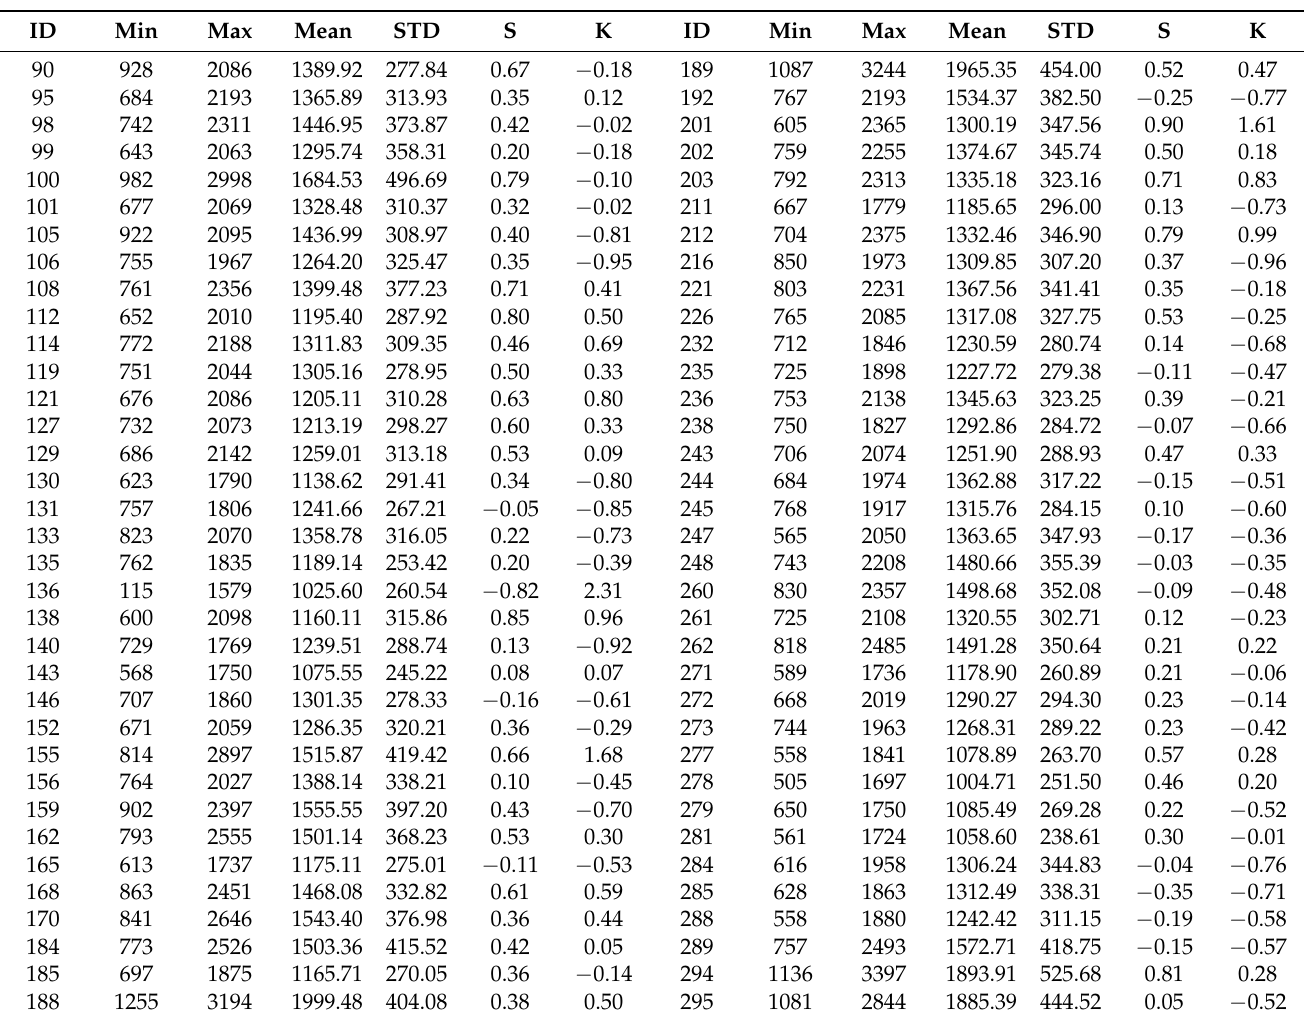
Table 3. Descriptive statistics of all meteorological stations in South